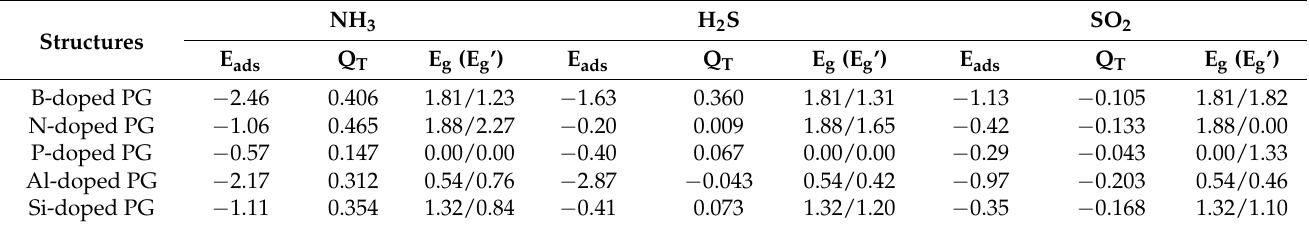
Table 3. Adsorption energy (E ads ) of various adsorption systems, Hirshfeld charge transferred from gases to doped PG (Q T ), and band gap of the system before adsorption (E g ) and after adsorption (E g ’). The positive (negative) Q T means that gases lose (gain)